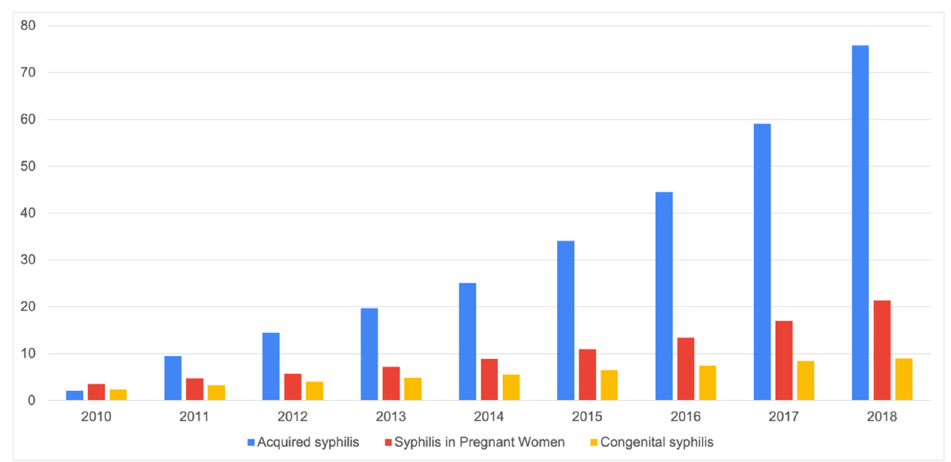
Figure 1. Reported cases of syphilis in Brazil between 2010–2018. Source: Ministry of Health (MoH). Then, in 2017, the MoH launched the “Syphilis No!” Project (SNP) [2–4]. With national coverage, the SNP was operationalized by dimensions in response to syphilis, in an inter- federative approach, within the Brazilian National Health System (SUS). For instance, the communication dimension aimed to disseminate the topic of syphilis nationwide